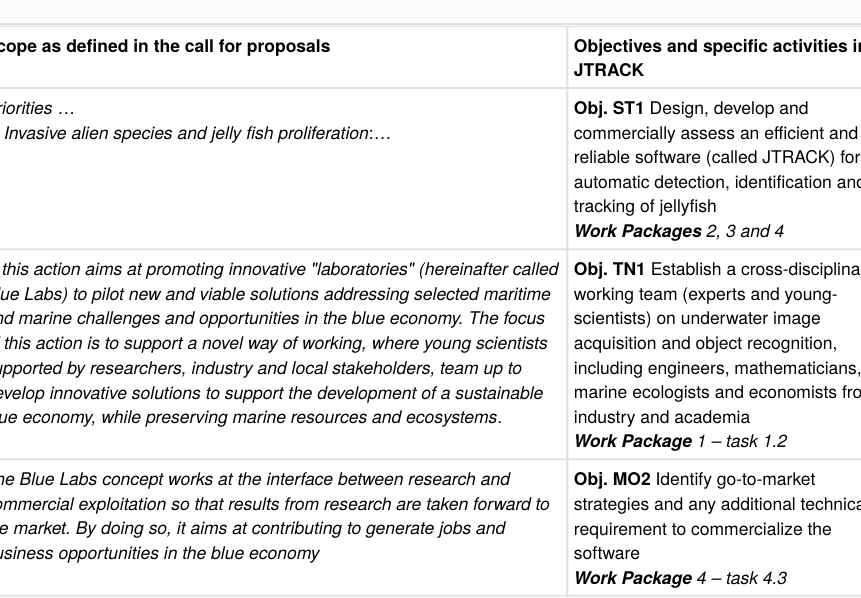
Comparison of call scope vs. JTRACK objectives and project